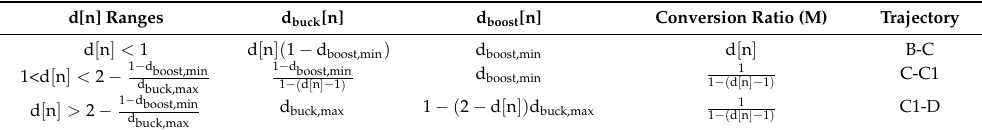
Table 2. Definition of (d buck [n],d boost [n]) pairs to go from B to D when d buck,max > 1 − d boost,min